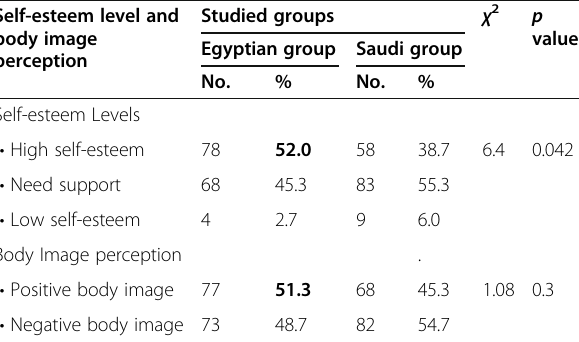
Table 5 Comparison between Egyptian and Saudi nursing students as regards self-esteem level and body image perception of each group ( n = 150) Self-esteem level and body image